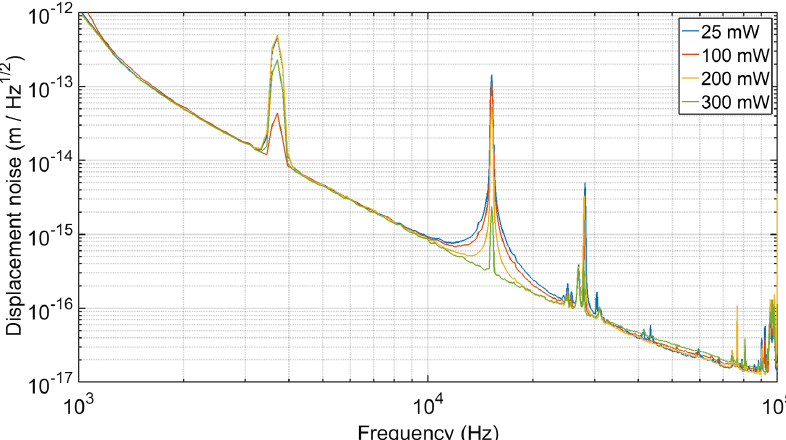
FIG. 5. Quantum-noise-free thermal noise spectrum measured at four different power levels. The measurement is performed by splitting the transmitted light onto two photodetectors and cross-correlating their outputs. The measured thermal noise remains constant across the range of powers at frequencies away from the resonances of the higher order modes. At frequencies near the higher order modes, the measured noise changes as a result of the change in cavity alignment due to the deflection of the cantilever by radiation pressure [12]. Realigning the beam at high power recovers the same thermal noise as measured with low power. There is no signature of QBA as